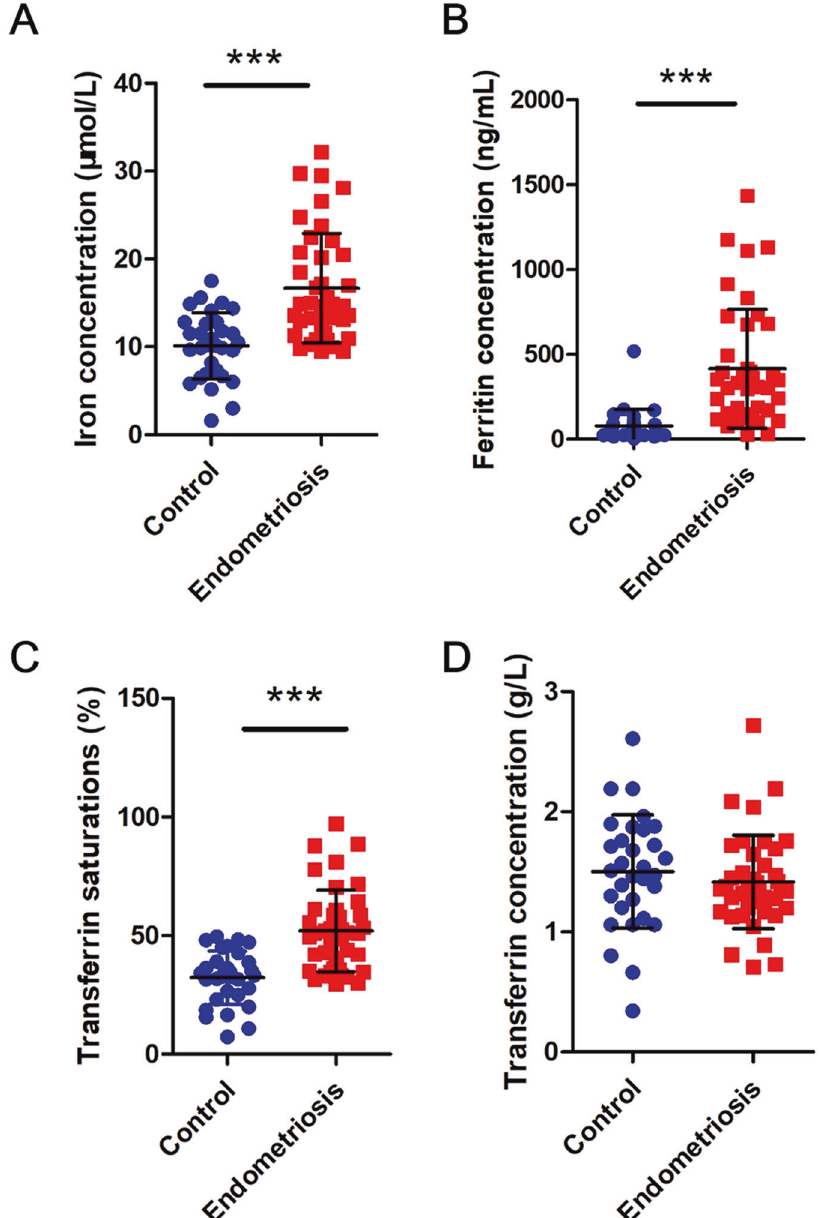
Fig. 1 Iron overload in peritoneal fl uid of endometriosis patients. A Iron concentration, B ferritin concentration, C transferrin saturation, D Transferrin concentration. Control ( n = 31) and endometriosis ( n = 41). *** P <